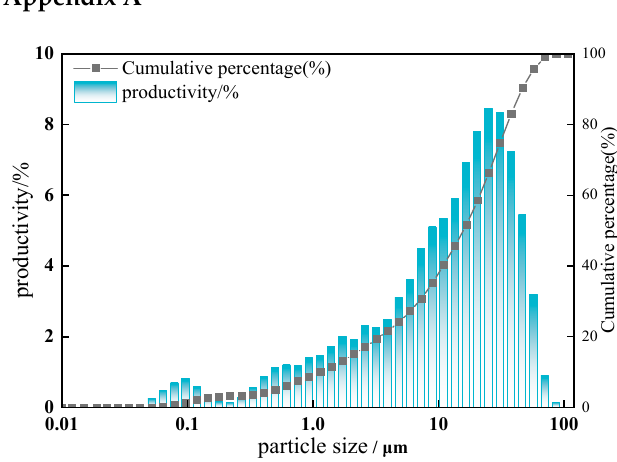
Figure A1. Particle size analysis of the Raw-Ka sample.